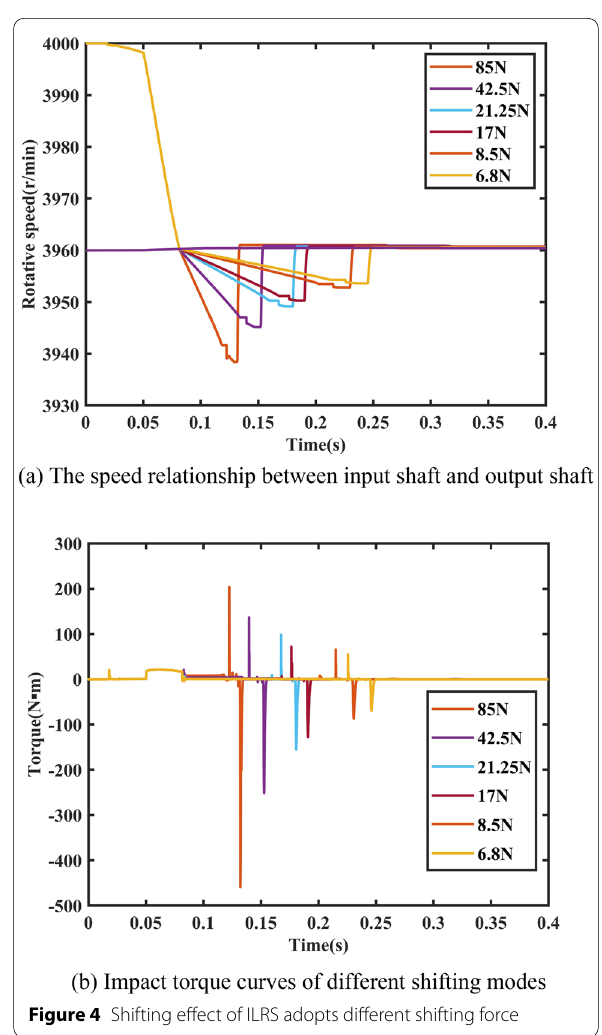
. Figure 4 Shifting effect of ILRS adopts different shifting